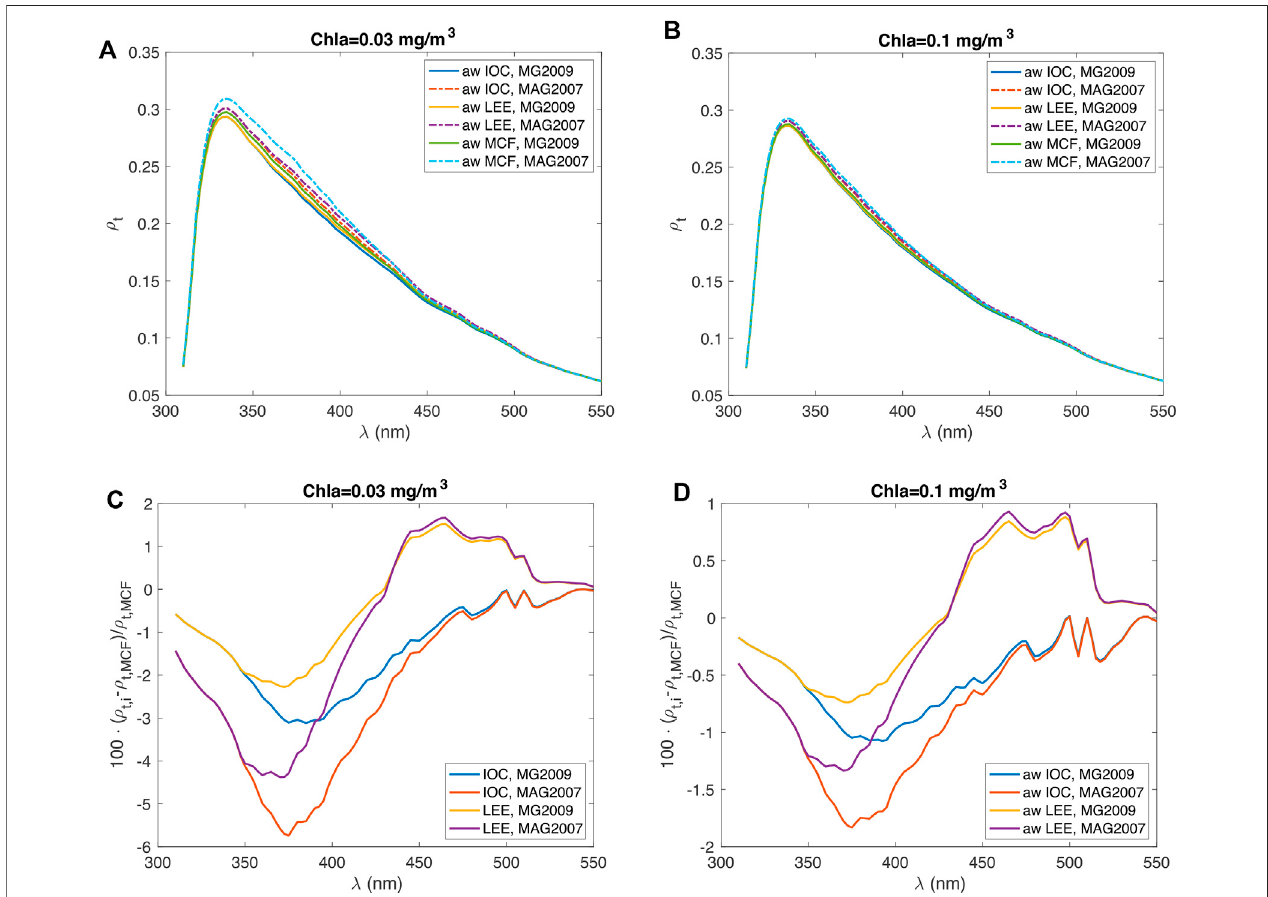
FIGURE 3 | (A) the total re fl ectance at TOA for [Chla] = 0.03 mg/m 3 . Six curves are shown, corresponding to three sources of water absorption coef fi cients times two different CDOM absorption parameterization in [Chla]. (B) the same as Figure 3A , except for [Chla] = 0.1 mg/m 3 . (C) the percentage difference of the TOA re fl ectance compared to MCF, where the subscript i in ρ t , i can be either IOC or LEE, as shown in the legend. (D) the same as (C) except for [Chla] = 0.1 mg/m 3 .